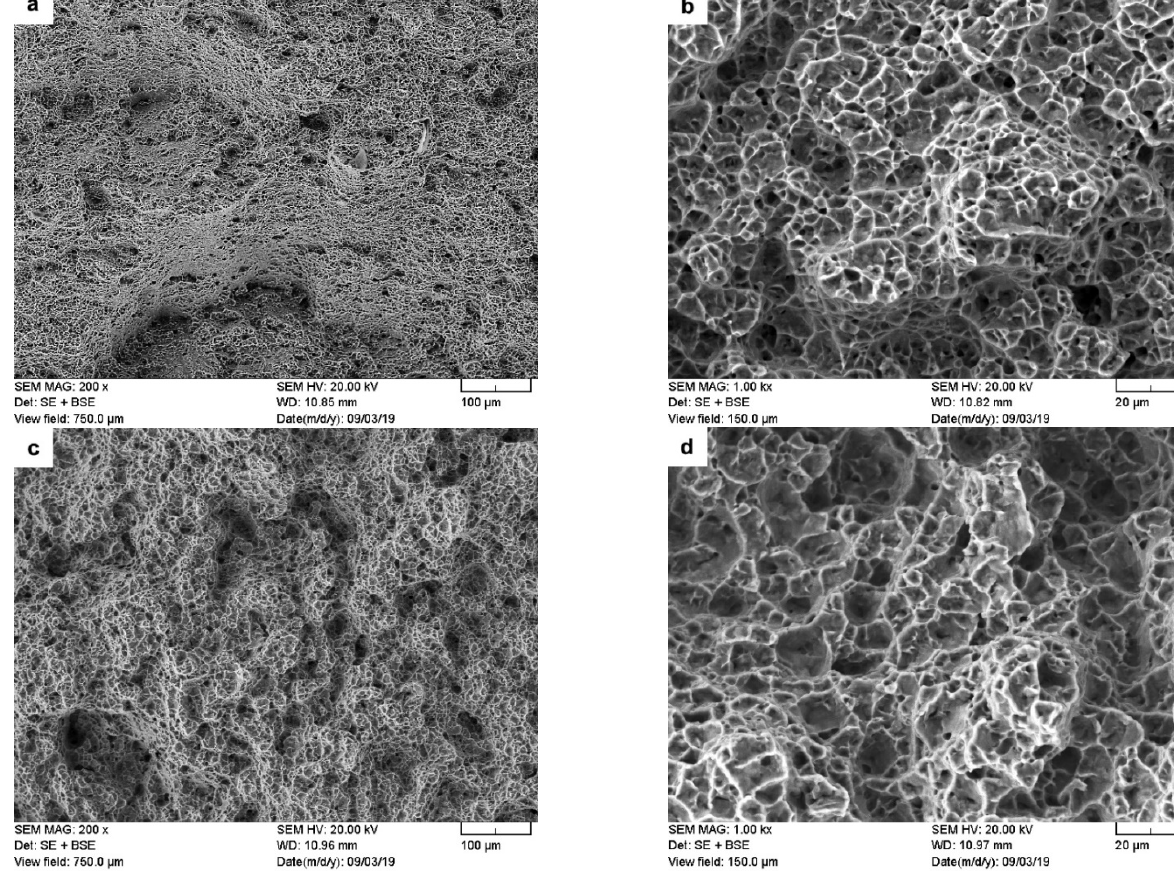
Figure 7. Secondary electron (SE) images of the tensile fracture surface for the ( a , b ) AWed and ( c , d ) SRAed conditions.